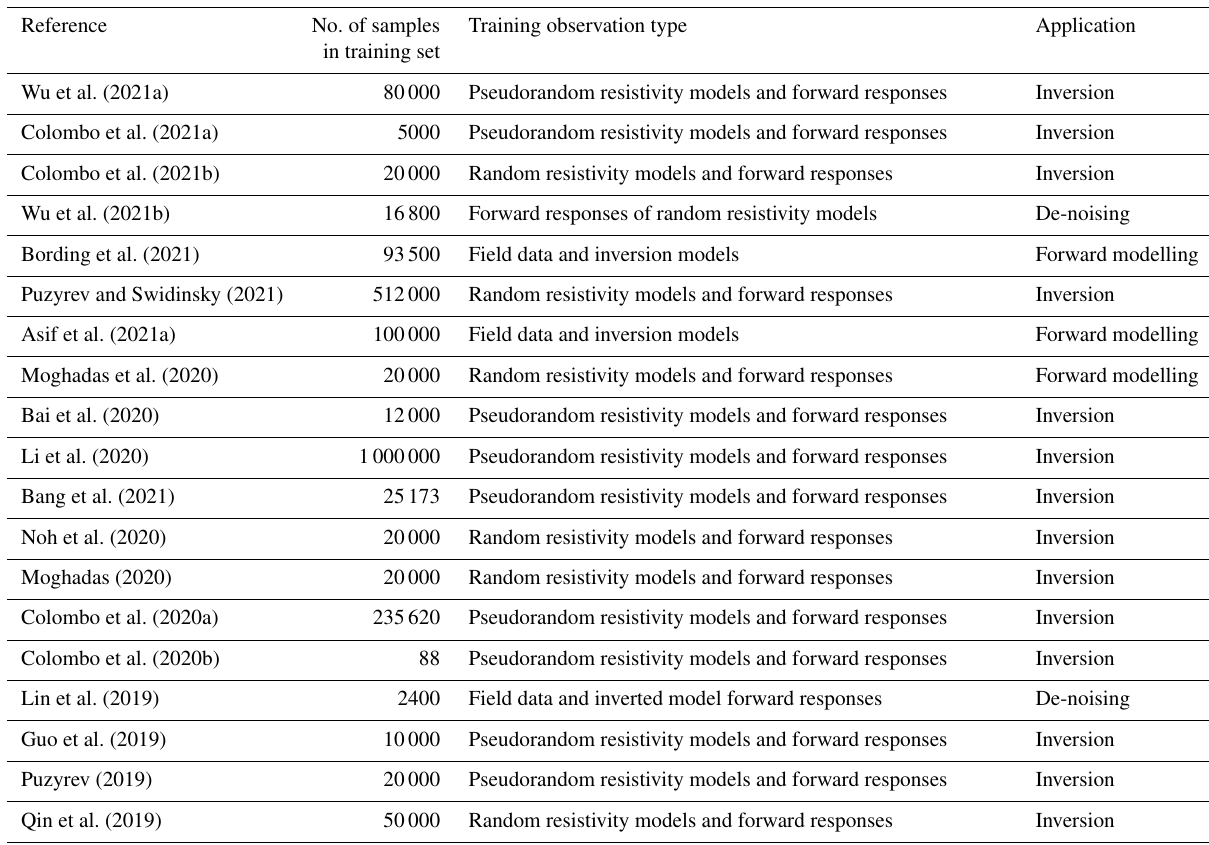
Table 1. Recent publications (2019–2021) of DL applications in EM which show the number of training samples and type of training dataset (random, pseudorandom, or field data).